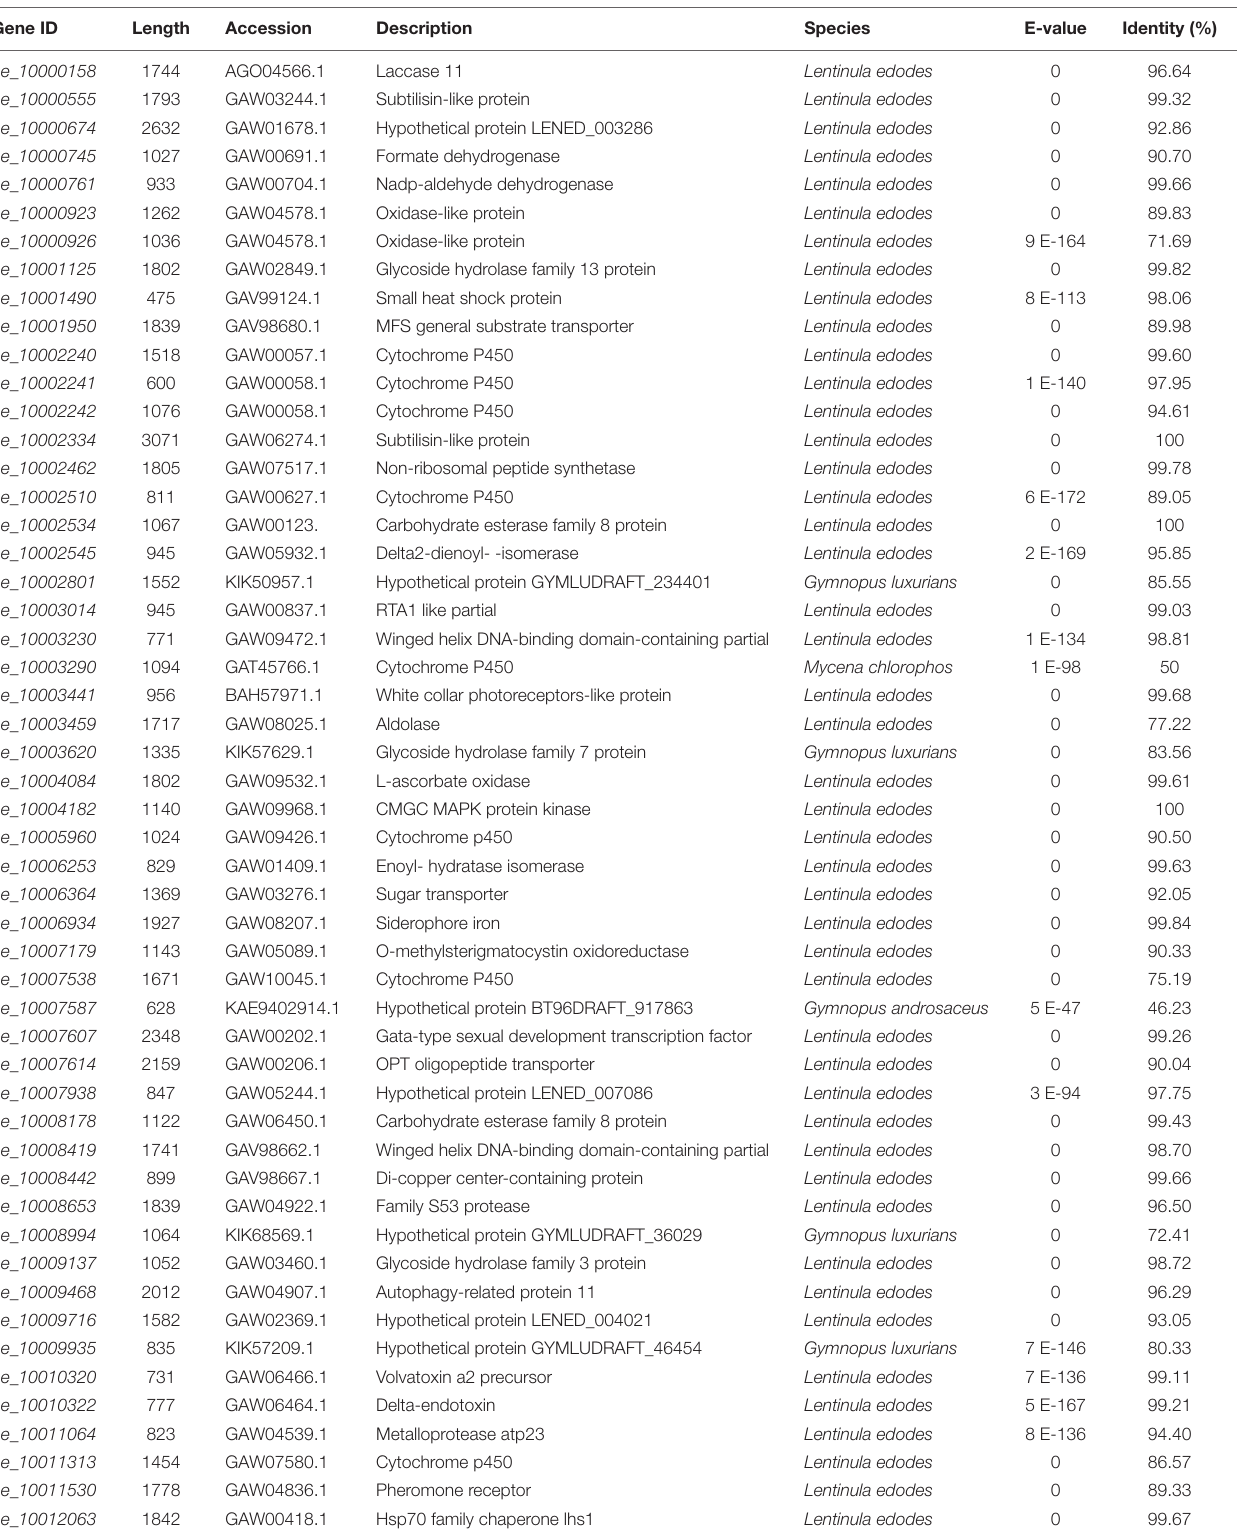
TABLE 1 | BLASTX results for function description of DEGs involved in different GO classification and KEGG pathways. Gene